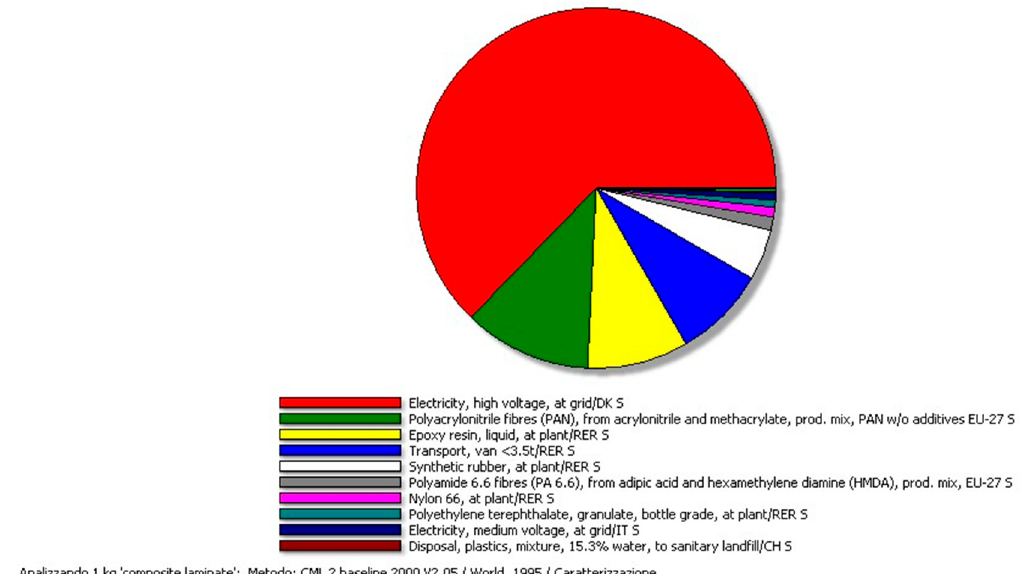
Figure 4. Production of CO 2 associated with the CF-composite. Electricity consumption, PAN, and epoxy resin are the main contributors.